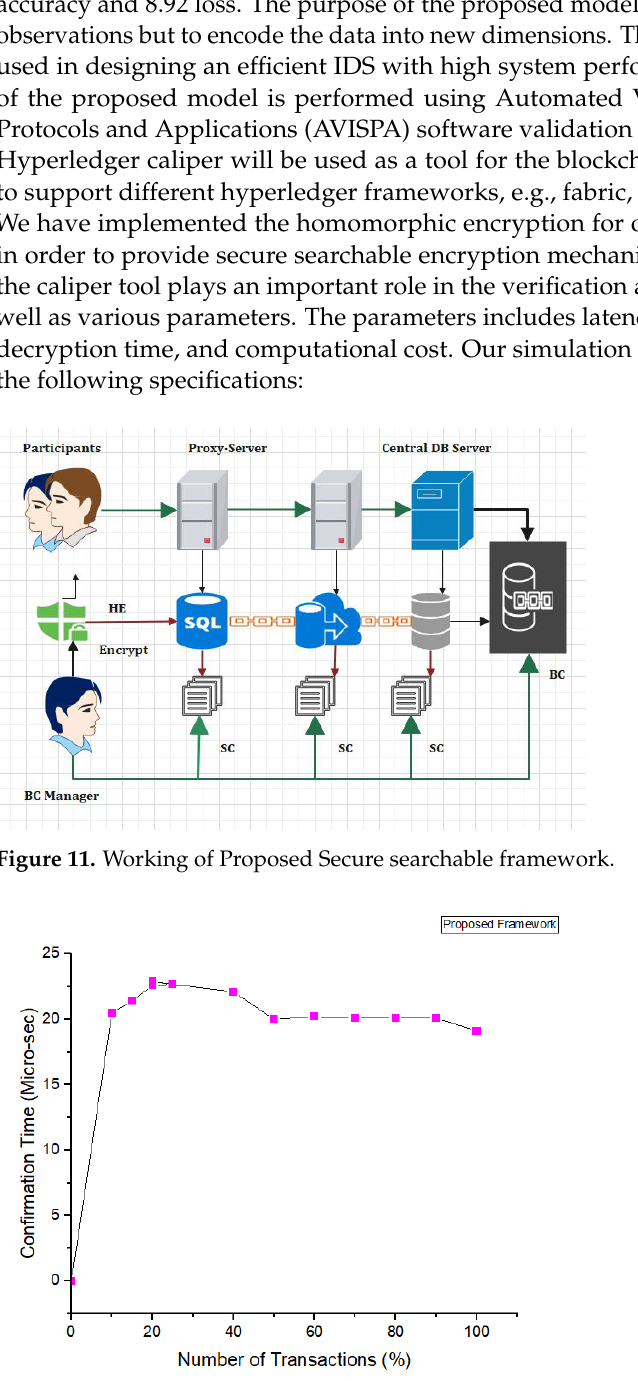
Figure 12. Simulations Results for proposed Method-Confirmation Time vs. no.